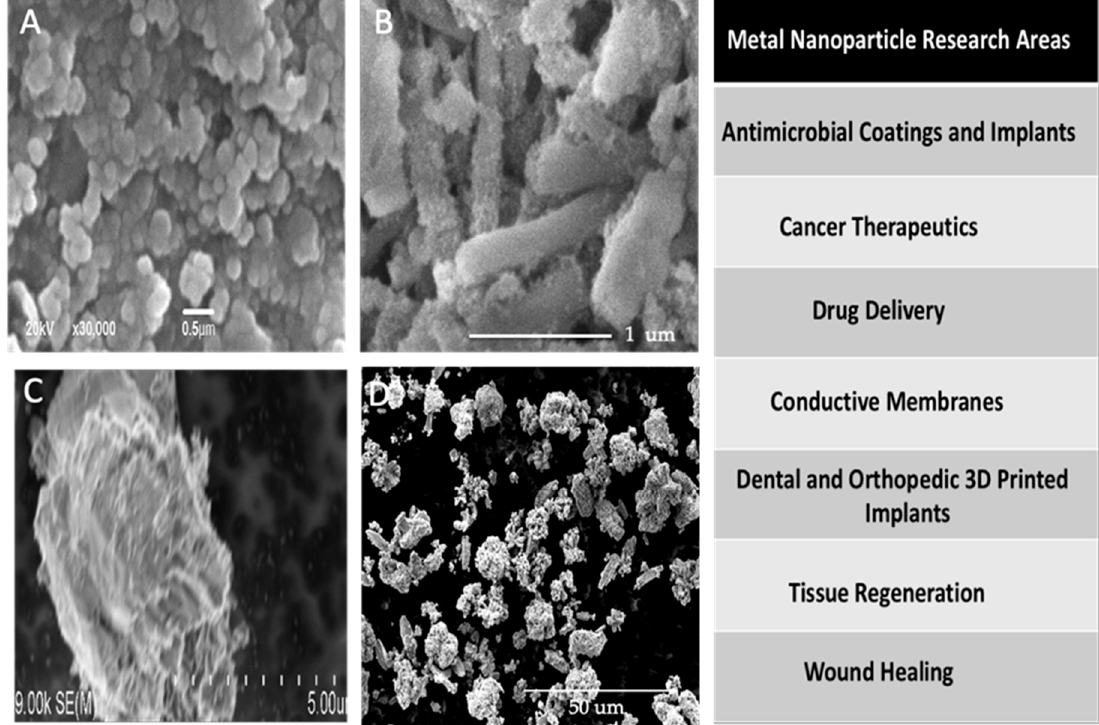
Figure 5. Metal nanoparticle types and areas of research interest. SEM micrographs of some of the more commonly used metal nanoparticles and application areas under intensive research. ( A ) Copper nnaoparticles; ( B ) Iron-coated HNTs). ( C ) Silver nanoparticles; ( D ) Zinc oxide nanoparticles. These